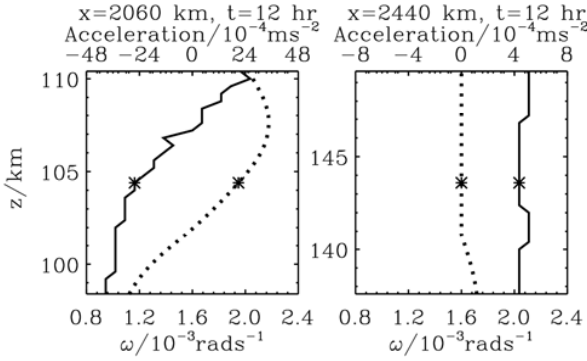
Fig. 4. Height variations of both the ground-based GW frequency (solid curves) and the tidal horizontal-wind acceleration (dotted curves) at 12h between the first and second critical layers (left) and above the second critical layer